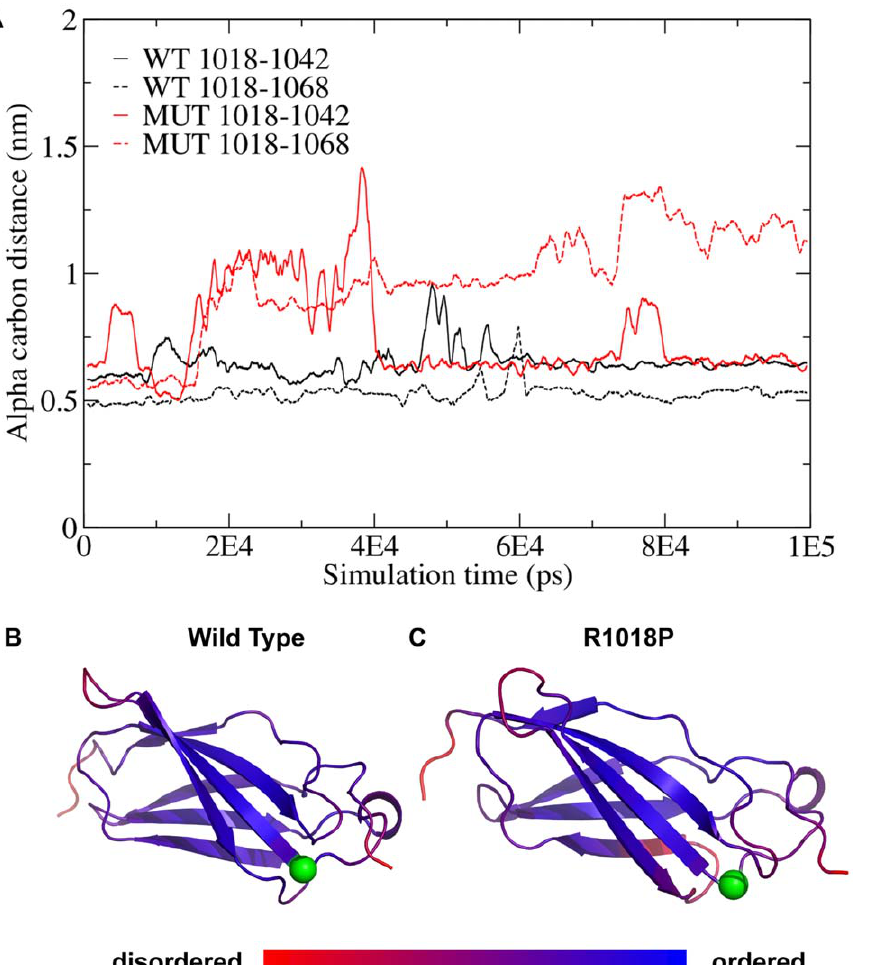
Figure 7. Molecular dynamics simulations suggest that the R1018P mutation destabilizes the DSCAM fibronectin domain. (A) Separation between the alpha carbon at the mutation site residue and two alpha carbons on neighboring loops as a function of simulation time. (B) Predicted structure of the wild type domain. The alpha carbon of amino acid 1018 is shown as a green sphere and the other colors represent the amount of fluctuation in the structure (blue=smallest fluctuations, red=largest fluctuations). (C) Same as panel B, but for the R1018P